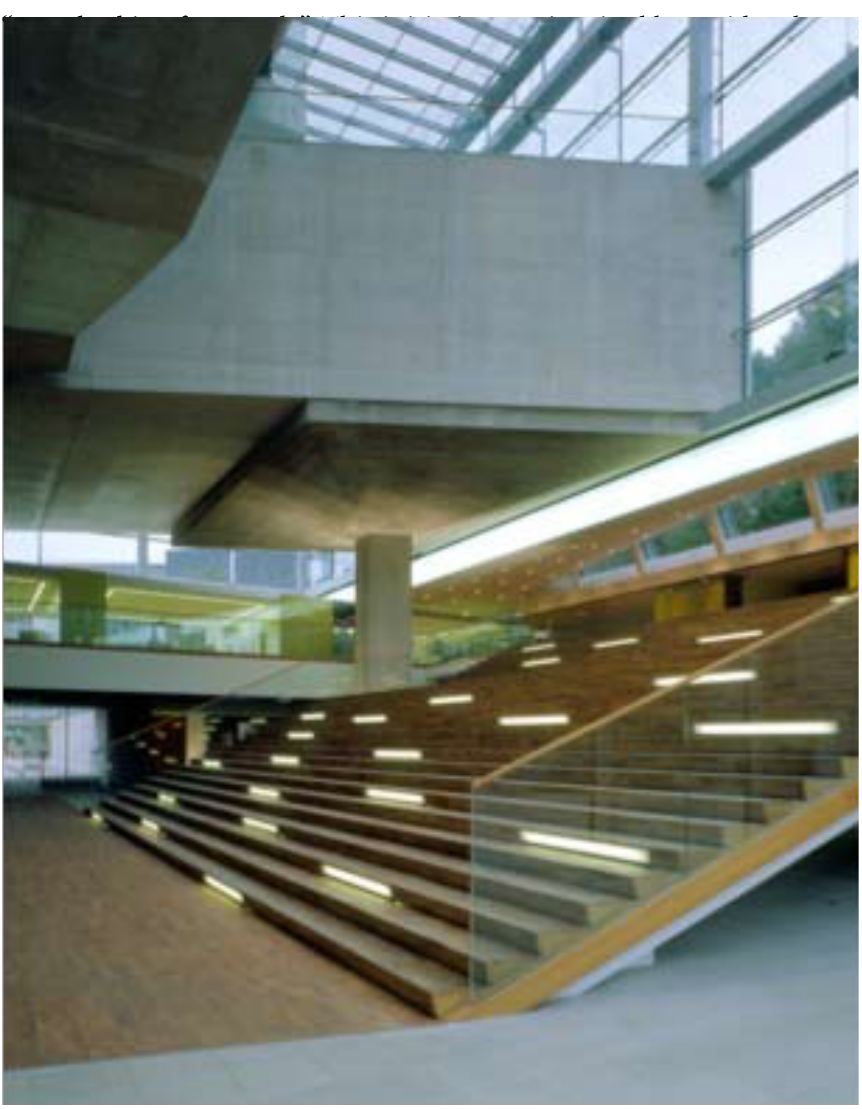
Picture 1: The staircase at The Museum of World Culture in Gothenburg gives form to the meeting-place metaphor as it is used by the head of the museum. Remarkably